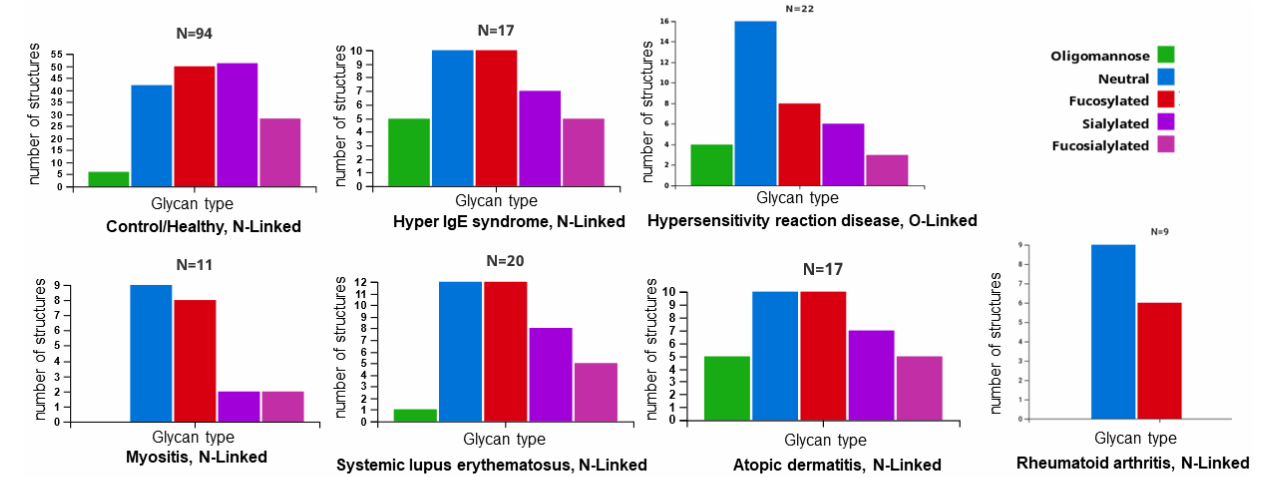
Figure 1. Compositional profiles of glycosylations related to diseases with alterations of the immune system. The number of glycans that have been associated with the indicated diseases is shown; in addition, the graphs show the frequency of sugars in the disease-related glycans. Neutral: does not contain sialic acid ( N -acetylneuraminic acid [NeuAc] or N -glycolylneuraminic acid [NeuGc]), nor sulfate